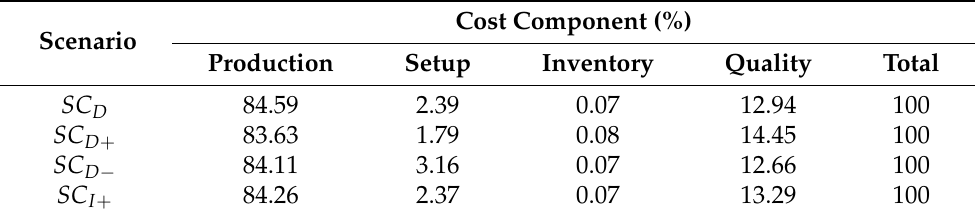
Table 3. Importance of cost components relative to overall optimal cost for 28d production horizon (deterministic consumption combined with absence of inventory